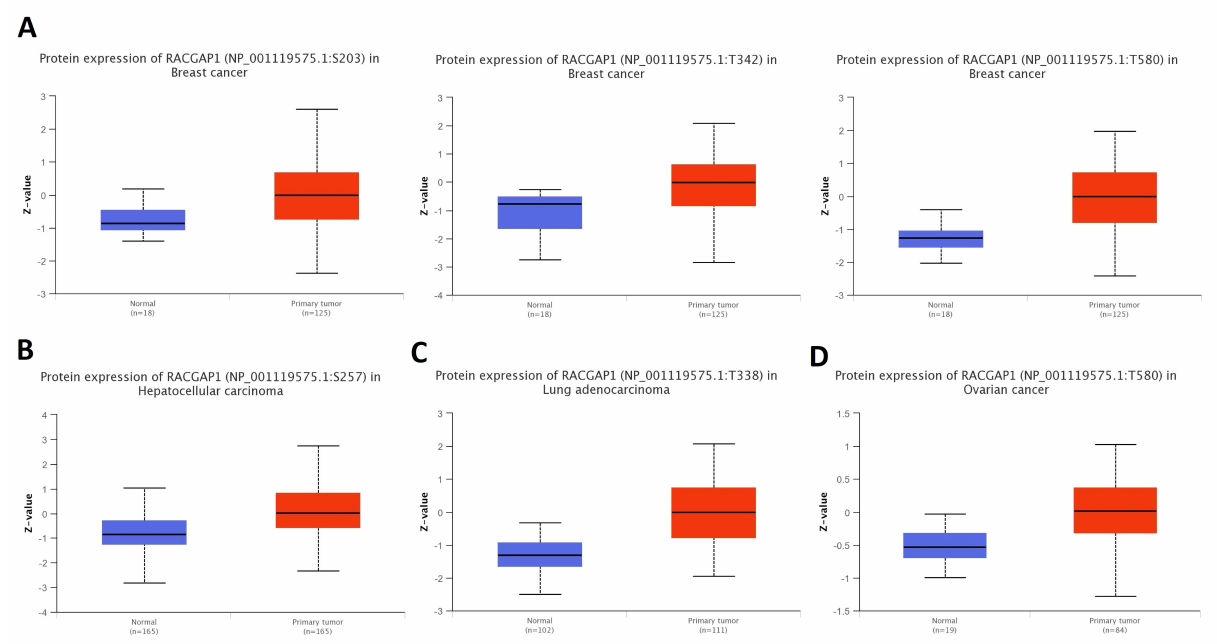
Figure 6. Differential phosphorylation analysis of RACGAP1 in tumor samples versus normal ones. ( A ) Breast cancer; ( B ) hepatocellular carcinoma; ( C ) LUAD; ( D ) ovarian